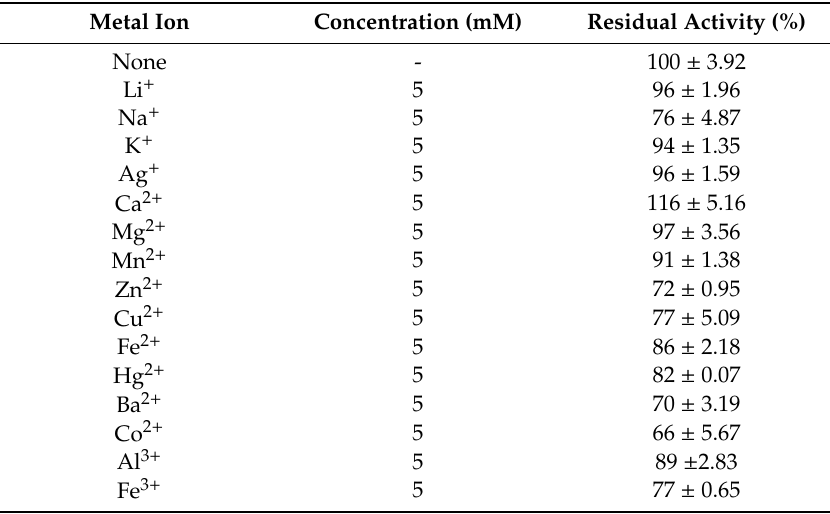
Table 4. E ff ect of metal ions on KerBNK1